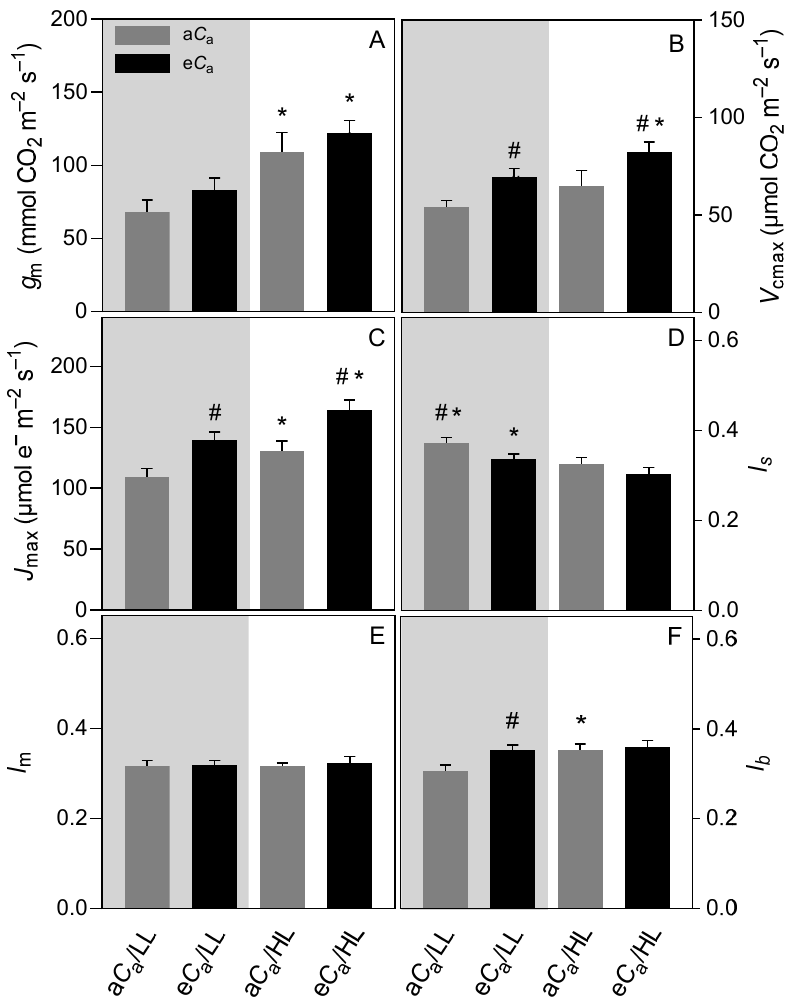
Figure 3. The effect of light intensity [low (grey area) or high (white area) light] and CO 2 supply [ambient (a C a ) or elevated (e C a ) supply] on photosynthetic traits of coffee plants: ( A ) mesophyll conductance to CO 2 ( g m ), ( B ) maximum apparent carboxylation capacity ( V cmax ), and ( C ) maximum rate of carboxylation limited by electron transport ( J max ), both on a chloroplast [CO 2 ] basis, and the functional components of the overall limitations to photosynthesis [( D ) stomatal ( l s ), ( E ) mesophyll ( l m ), and ( F ) biochemical ( l b ) limitations]. Asterisk (*), when shown, indicates differences between light regimes within the same CO 2 supply. Pound (#), when shown, indicates differences between CO 2 treatments within the same light regime ( p ≤ 0.05, F test, n = 6 ± SE). The e C a promoted overall increases in V cmax (HL: 27%, LL: 28%) and J max (HL: 25%, LL: 28%). The J max / V cmax ratio did not respond to the treatments and averaged on ca. 2.0, as can be deduced from Figure 3.